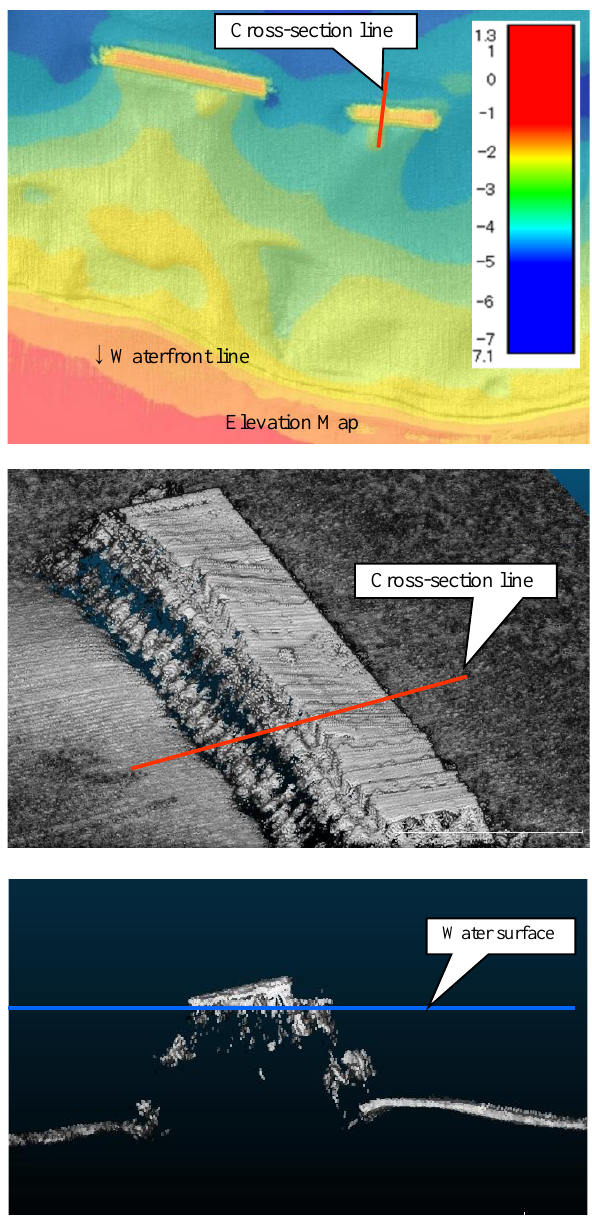
Figure6. Elevation Map, Bird's-eye view and Cross-section Around Breakwater 5. CONCLUSTION Through verification of experimental measurements, the following knowledge was obtained about the measurement accuracy and measurement characteristics of Green LiDAR